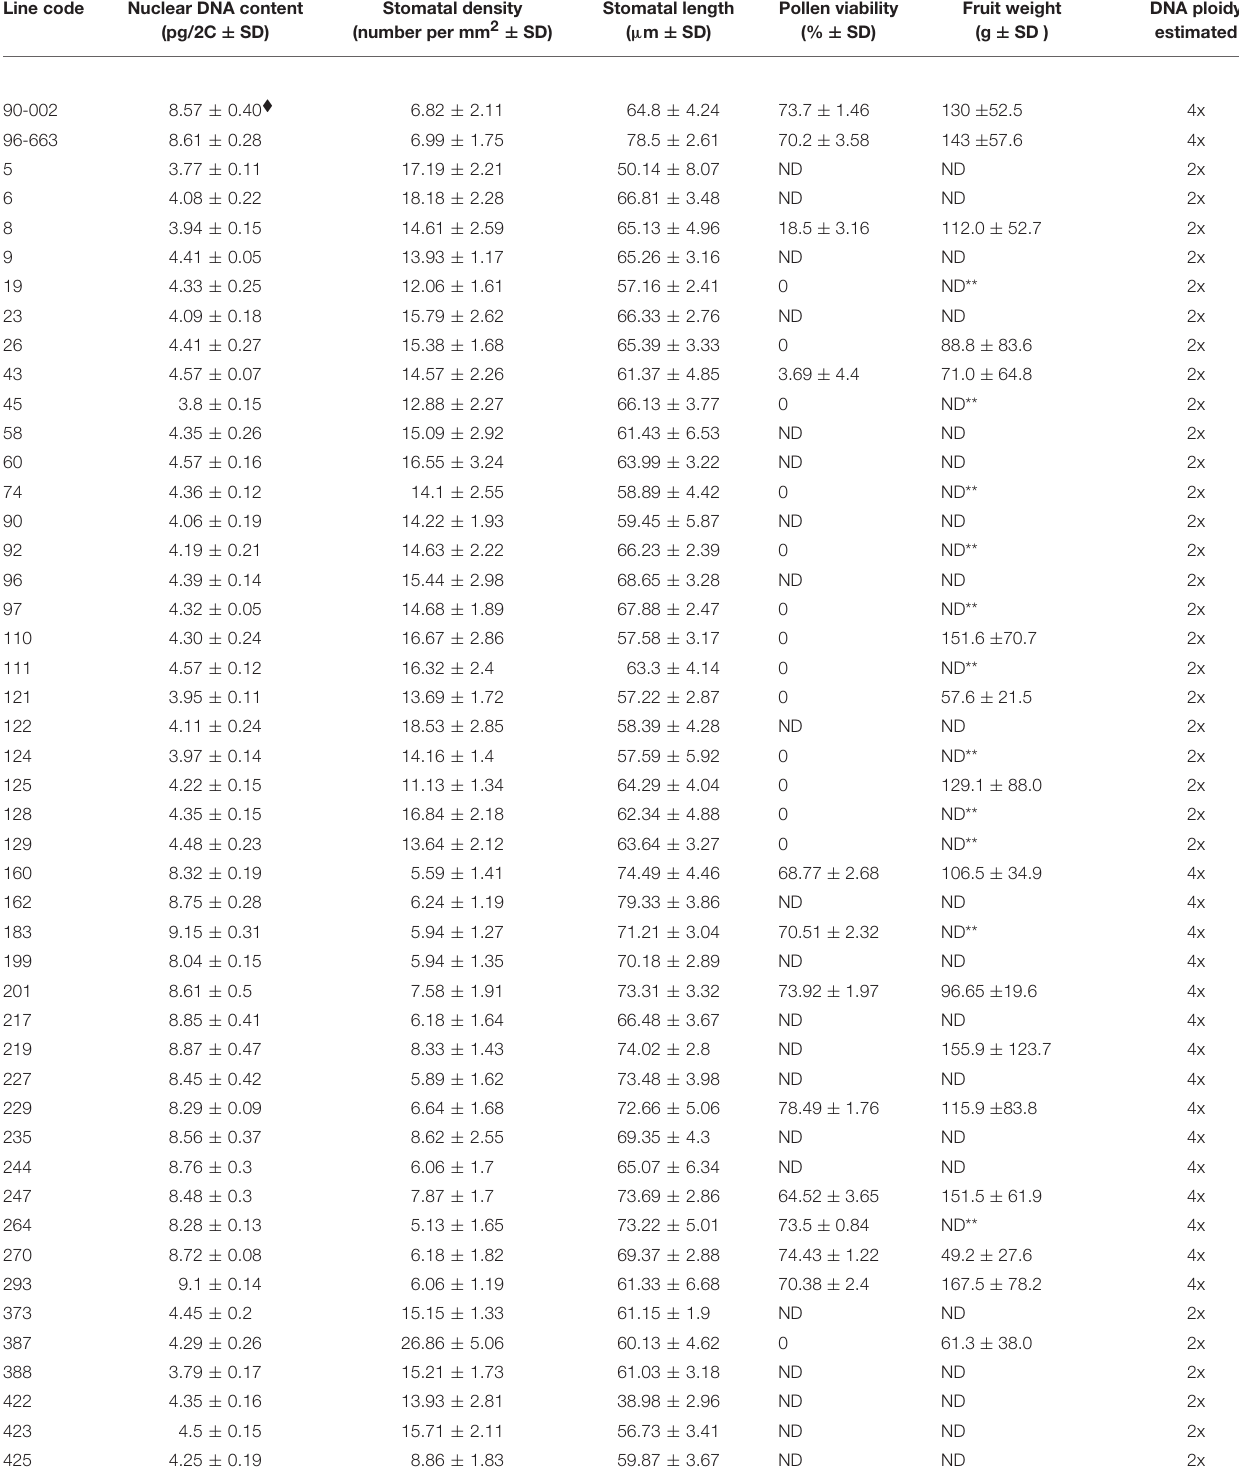
TABLE 2 | Nuclear DNA content, stomatal density and length, pollen viability, fruit weight and DNA ploidy estimation in putative gamete-derived lines from the tetraploid donor H. megalanthus (accessions 90-002 and 96-663). Line